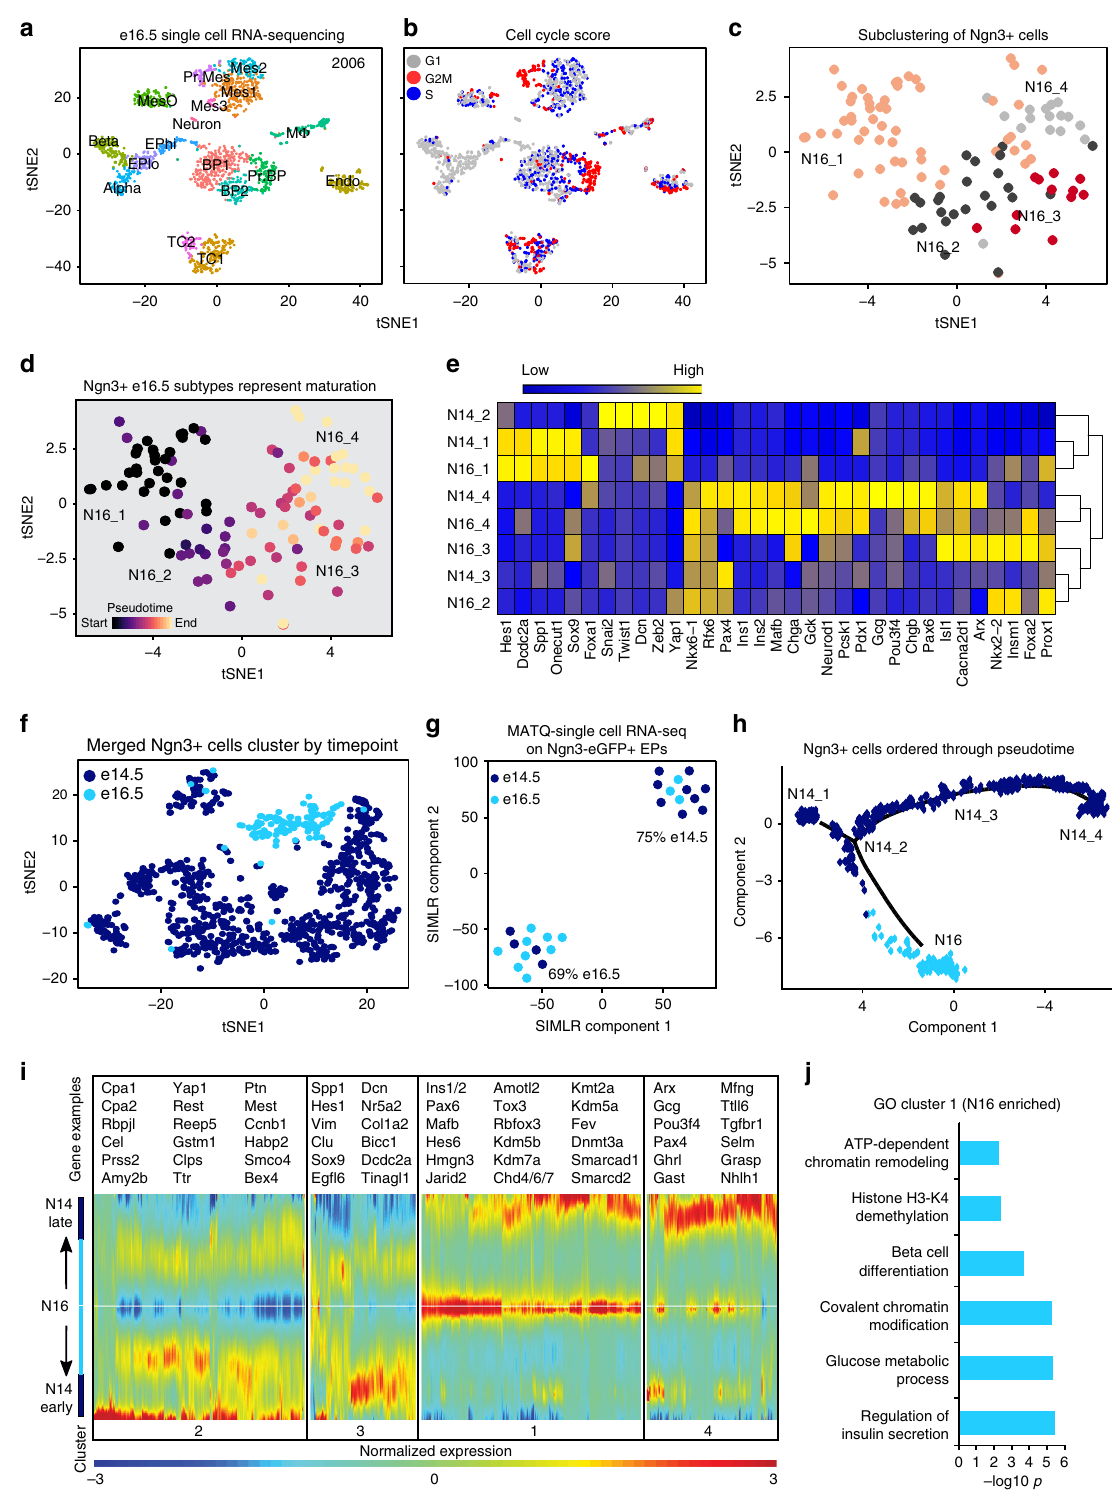
EP chromatin accessibility shifts from e14.5 to e16.5 . The increase in expression of epigenetic regulators associated with the beta cell fate in e16.5 Ngn3 + cells concurrent with increased beta cell and decreased alpha cell genes led us to investigate the contribution of the chromatin state in diverting EPs to become alpha or beta cells. We found changes in epigenetic regulator expression in EPs, some with known functions in endocrine cell